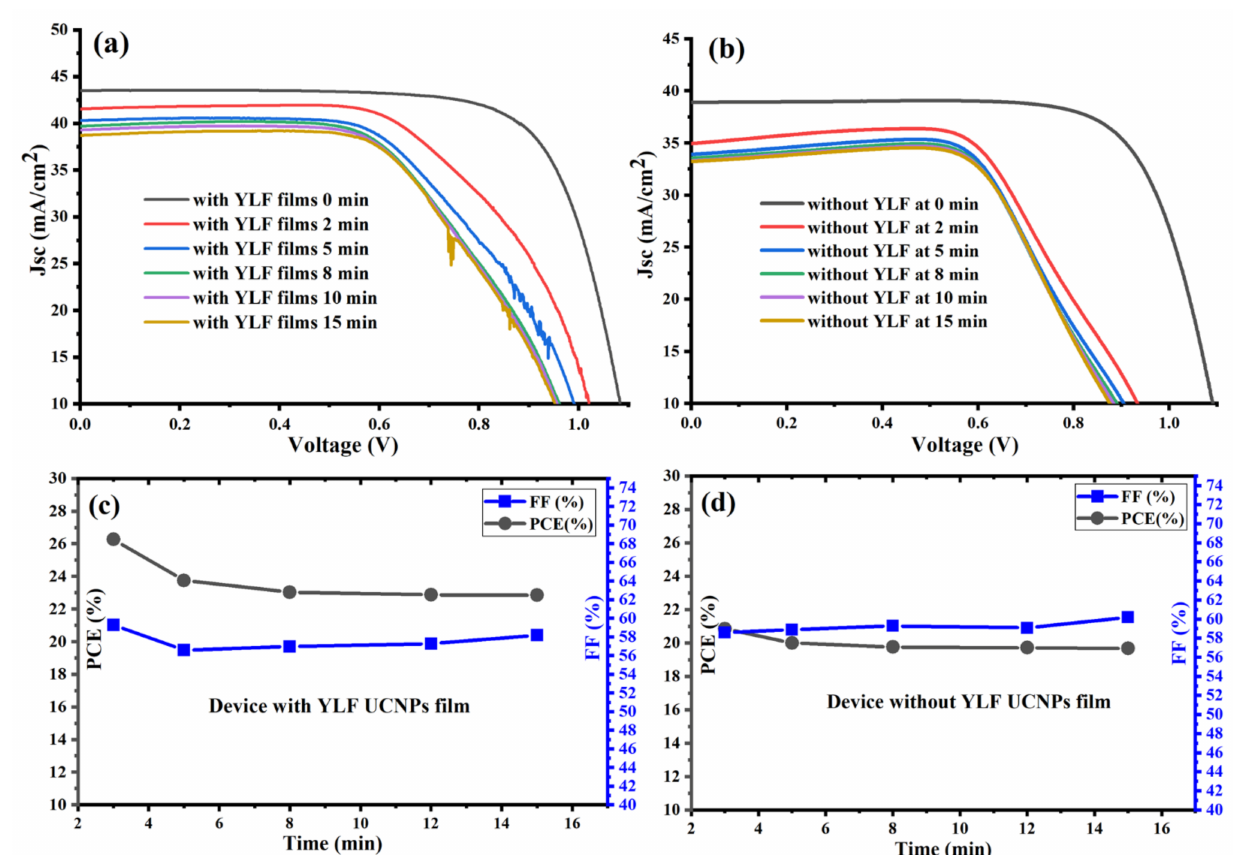
Figure 4. ( a , b ) J-V characteristic curves measured under concentrated AM 1.5 G for fabricated PSCs with and without UC thin films. ( c , d ) Power conversion efficiency (PCE) and fill factor (FF) of fabricated PSCs with and without UC thin films under a continuous concentrated light without cooling system